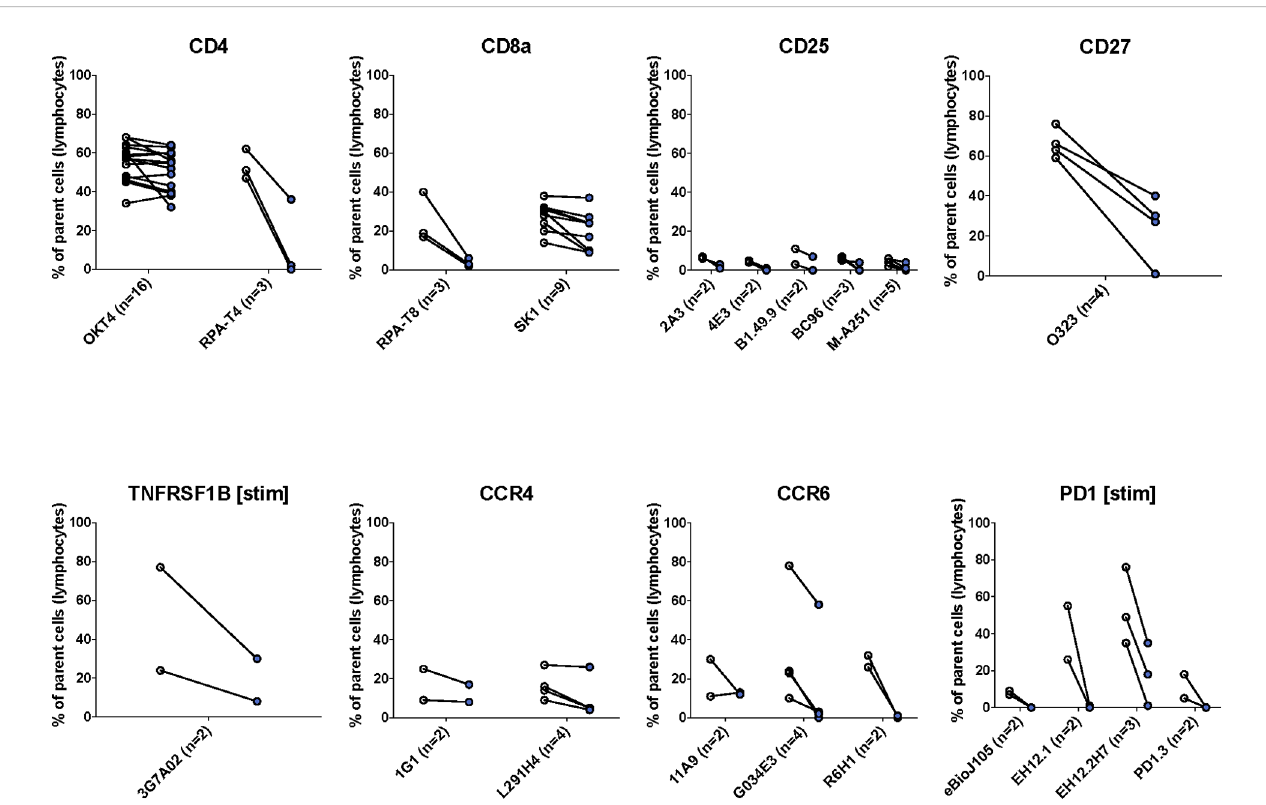
FIGURE 3 The effects of enzymatic digestion on key phenotypic markers of concern in the TotalSeq-C antibody library. White and blue circles indicate pre- and post-digestion values, respectively. Each pairing signi fi es an independent experimental replicate of pre- and post-treatment measurements, and the proportion of cells positive for the marker of interest was determined using standard fl ow gating. Parent cells were total live lymphocytes after applying quality control gating as outlined in Supplemental Figure